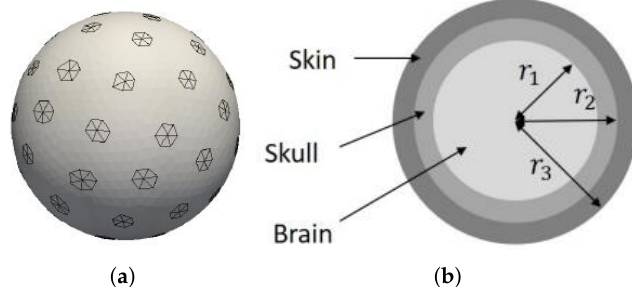
Figure 2. Head model with electroencephalography (EEG) electrodes: ( a ) PEC electrodes formed by triangles lying on the surface of the discretized three-layer sphere, and ( b ) three-layer spherical head model.